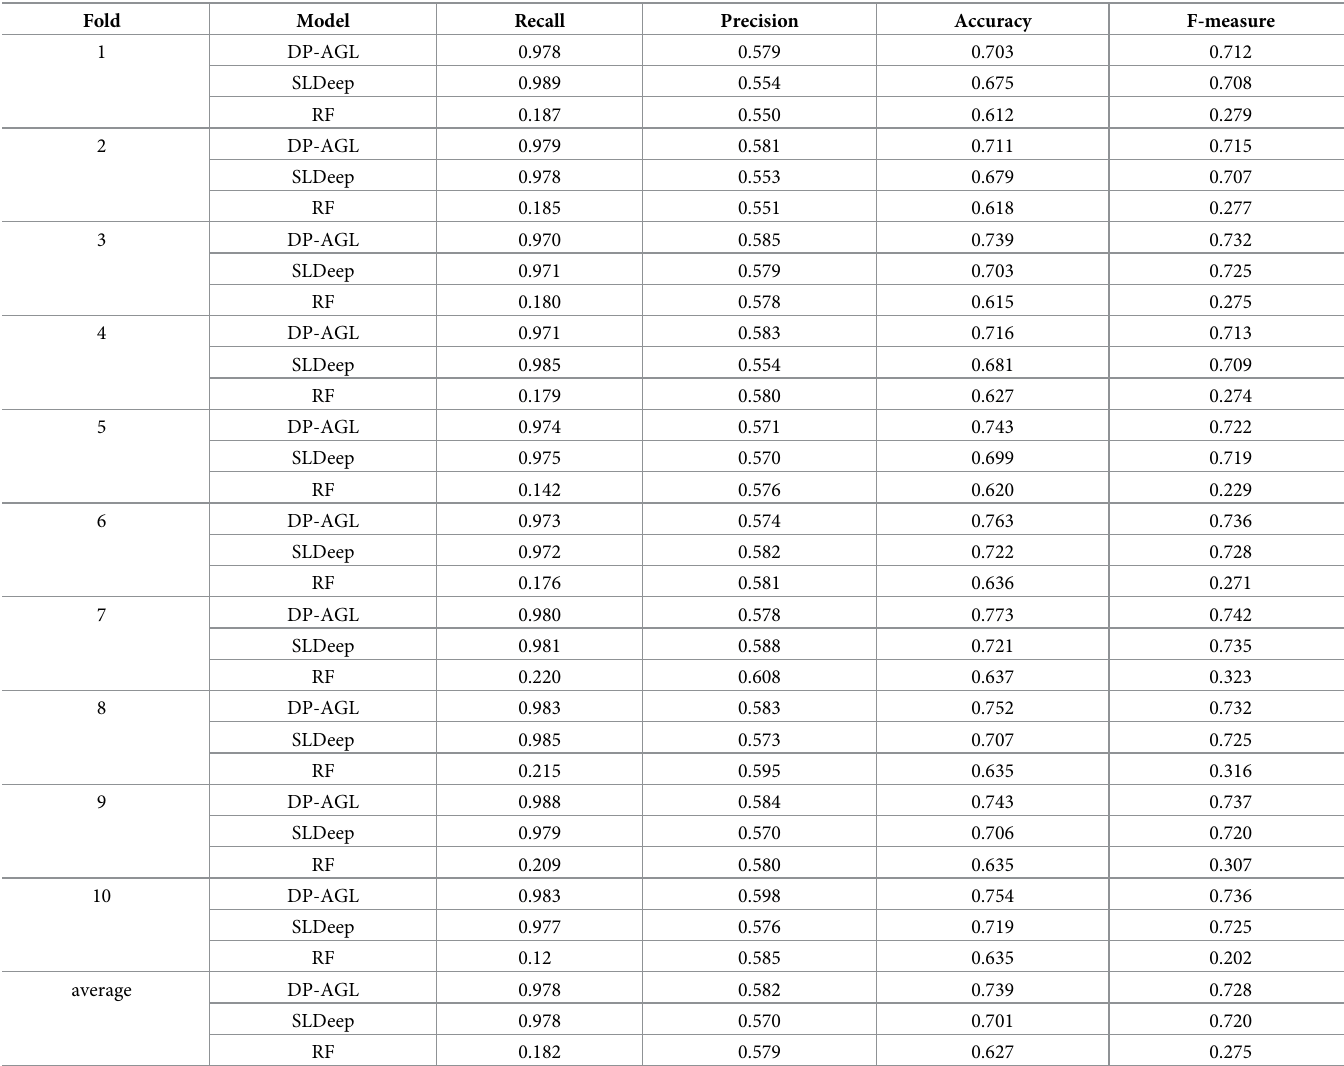
Table 4. Experimental results on testing with accuracy neighborhood 4.